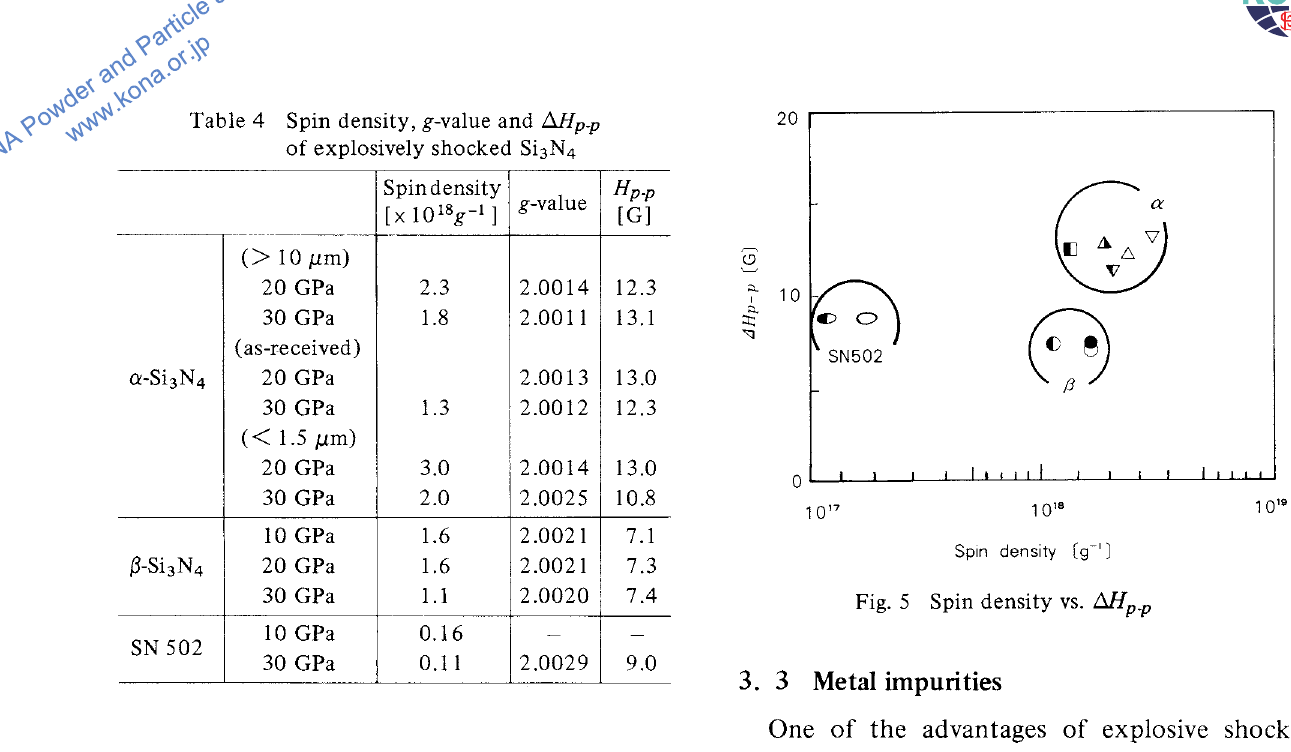
Table 4 Spin density, g-value and 11Hp-p of explosively shocked Si3N4 Spin density g-value [x 101sr1J